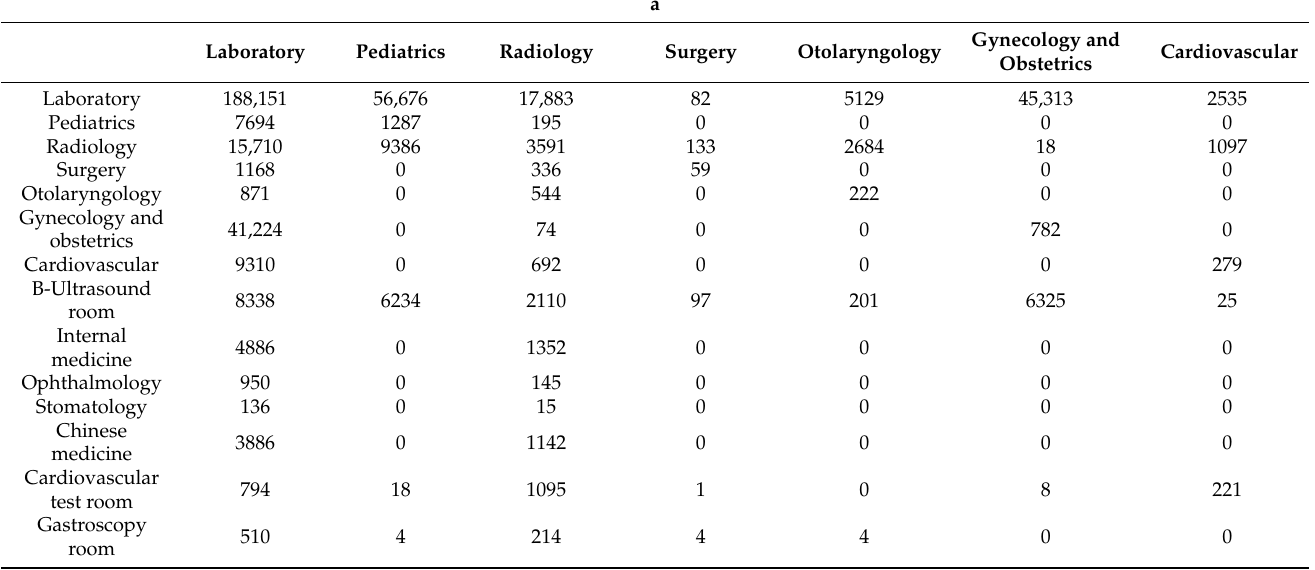
Table 6. Patient